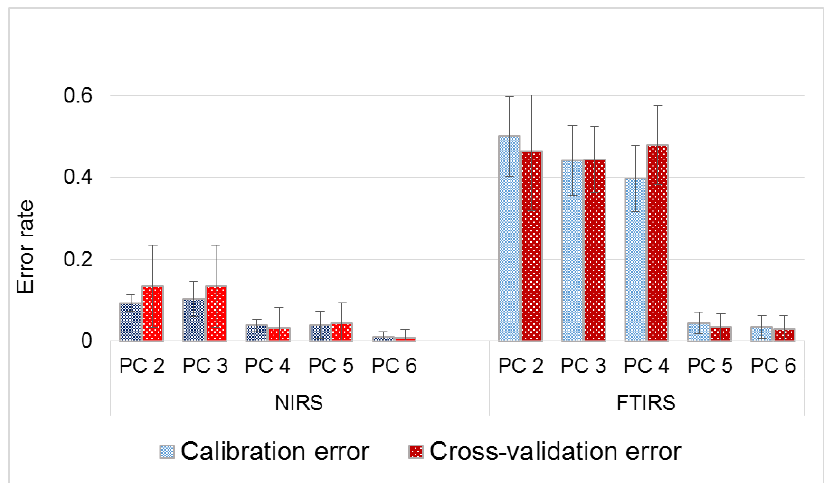
Figure 7. Effect of changing number of PCs on classification error.